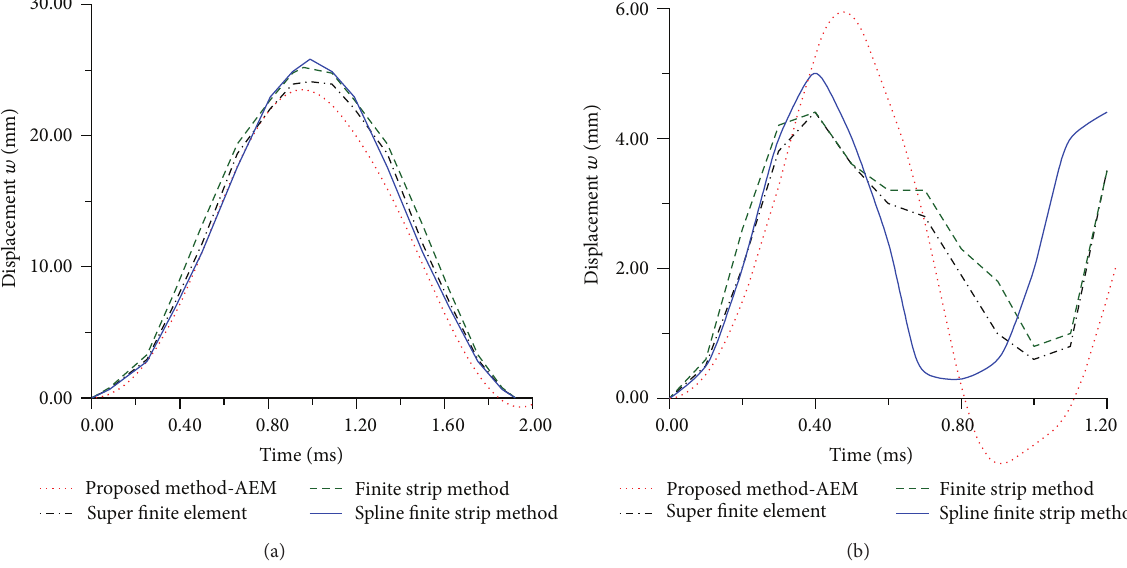
Figure 11: Time history of linear (a) and nonlinear (b) response of the deflection 𝑤 (mm) of the half panel center A of the stiffened plate of Example 2.